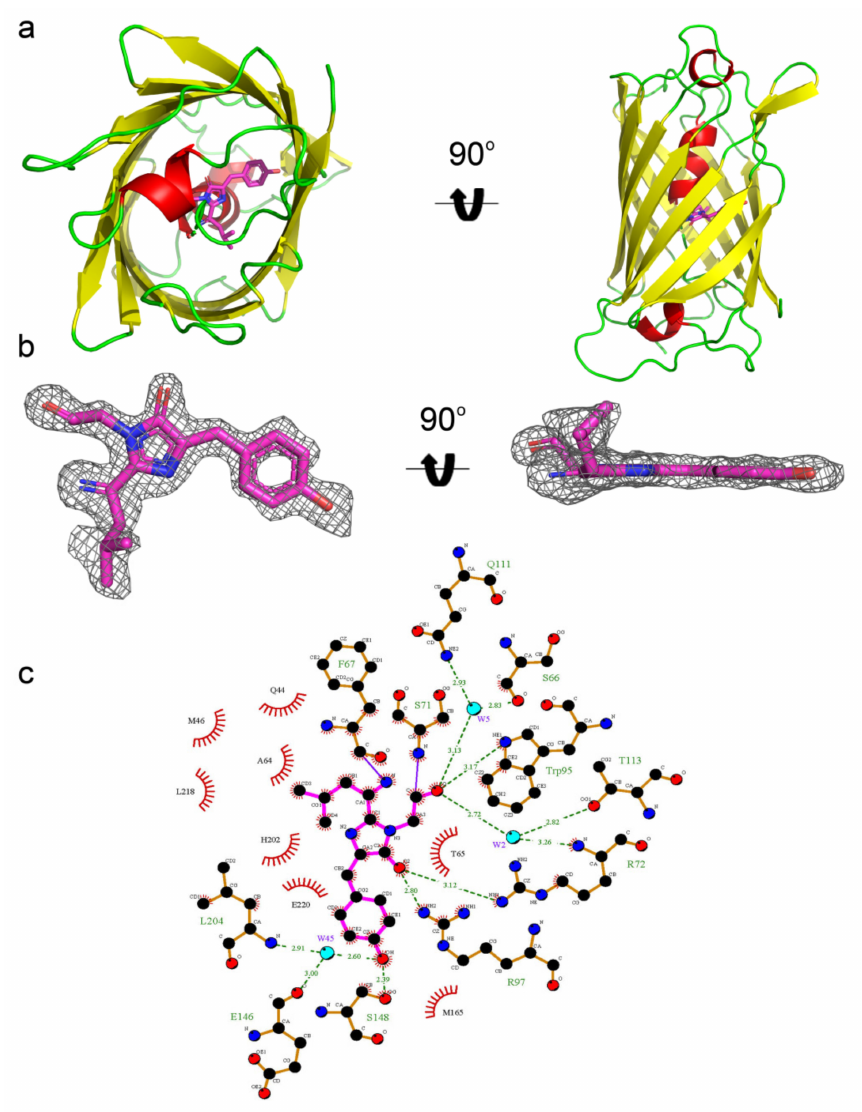
Figure 6. X-ray structure of the red form of the mRubyFT protein. ( a ) Cartoon representation of the overall red mRubyFT monomer. Chromophore, β -sheets, α -helixes, and loop regions are shown in pink, yellow, red, and green colors, respectively. The orientation of the panel on the right is rotated 90 ◦ around the horizontal axis with respect to that on the left. ( b ) The omit electron density map (Fo-Fc) around the chromophore of the red mRubyFT protein. The map is contoured at 1.0 σ level and shown as gray mesh. The orientation of the chromophore on the right is rotated 90 ◦ around the horizontal axis with respect to that on the left. ( c ) The immediate environment of the red mRubyFT chromophore. Chromophore is shown in magenta, residues forming hydrogen bonds in orange, and other residues nearby are shown in red. Hydrogen bonds are depicted as green dashed lines and correspondent distances are labelled. Water molecules are shown as cyan